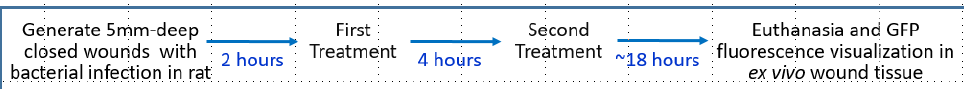
Figure 6. Representative images of deep skin wound tissue after 1 ( A ) and 3 ( B ) hours of initiating infection with GFP- E. coli . Histograms show the quantification of the depth ( C ) and width ( D ) of infection in the skin. n = 3 per group. a.u.: arbitrary units. ** p < 0.01. This indicates that GFP- E. coli infection was present at a depth of >5 mm from the top of the skin. The average depth and width of GFP fluorescence was 7.9 ± 0.7 mm and 2.1 ± 0.4 mm, respectively, after three hours of inducing the infection (Figure 6C–D). This observation further confirms the presence of robust E. coli infection after 3 h of introducing these bacteria to the deep skin wound. We used intraperitoneal (IP) injection of CMS as the mode of systemic delivery of CMS to rats with deep skin infections. Figure 7A,B show representative images of wound tissues from rats treated with IP delivery of either saline or CMS (2.5 mg/kg in 300 µL). The depth of robust GFP fluorescence present in the wound tissue in the rats treated with IP delivery of saline had an average of 5.7 ± 0.4 mm from the top of the skin after 24 h